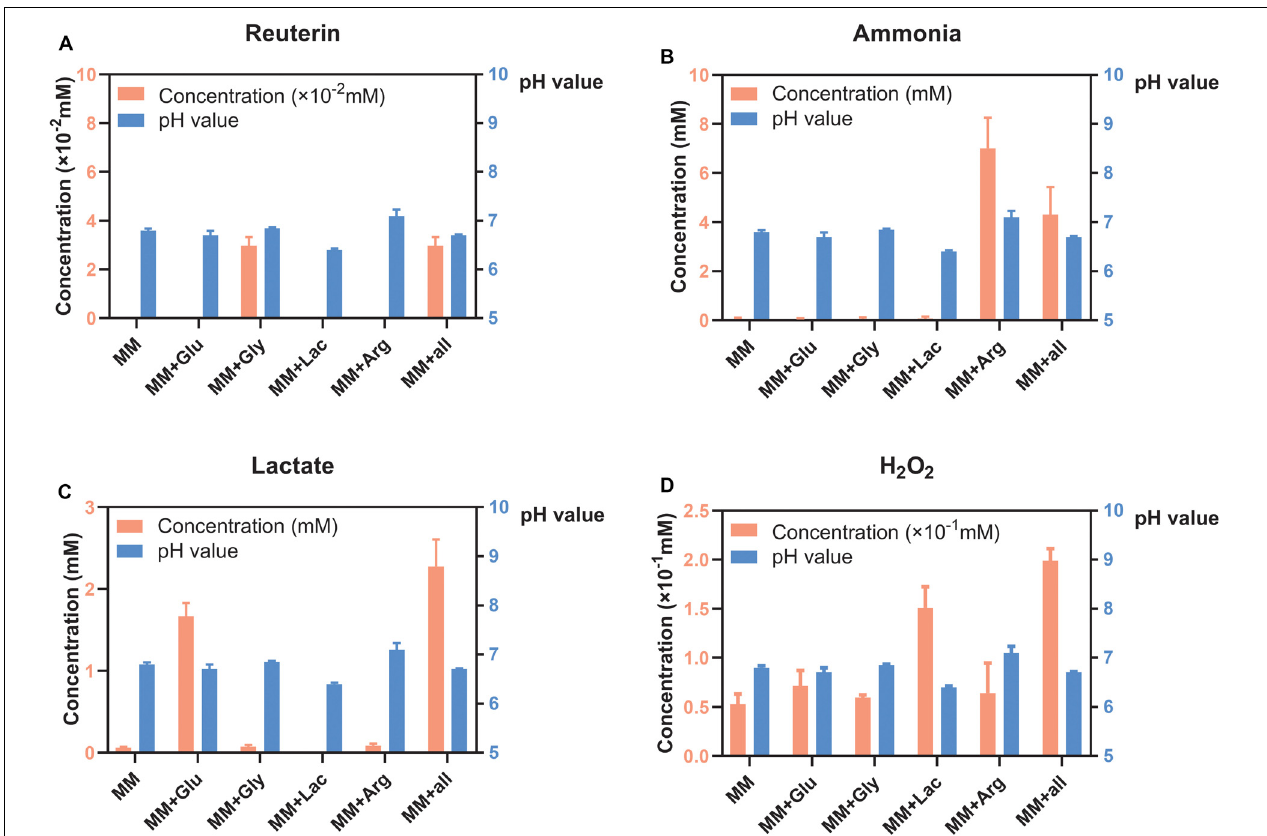
FIGURE 1 | Concentration of metabolites and pH of S. oligofermentans in six different MM media (means ± standard deviations, n = 3); minimal medium (MM), MM with glucose (MM+Glu), MM with glycerol (MM+Gly), MM with Lactic acid (MM+Lac), MM with arginine (MM+Arg) and all-full medium (MM+all). The left Y axis showed the concentration and the right Y axis showed the pH value. (A) Very little reuterin was produced in S. oligofermentans . (B) Ammonia was detected in MM+Arg and MM+all. (C) Lactate was detectable mainly in MM+Glu and MM+all. (D) H 2 O 2 was produced in all